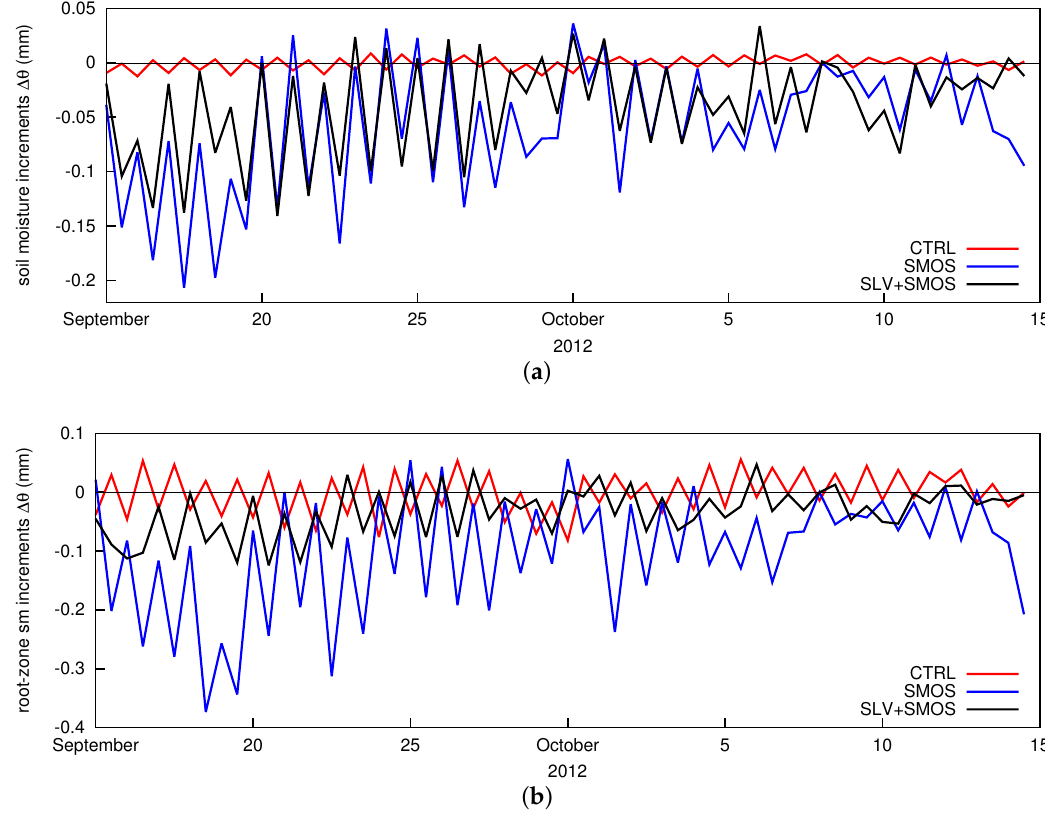
Figure 3. Time series of the 12 h area averaged analysis increments of the control SLV (red curve), SMOS (blue curve) and SLV+SMOS (black curve) experiments for the: ( a ) top 7 cm; and ( b ) the root-zone layer. Note that the OL experiment is not shown here because it is not an analysis